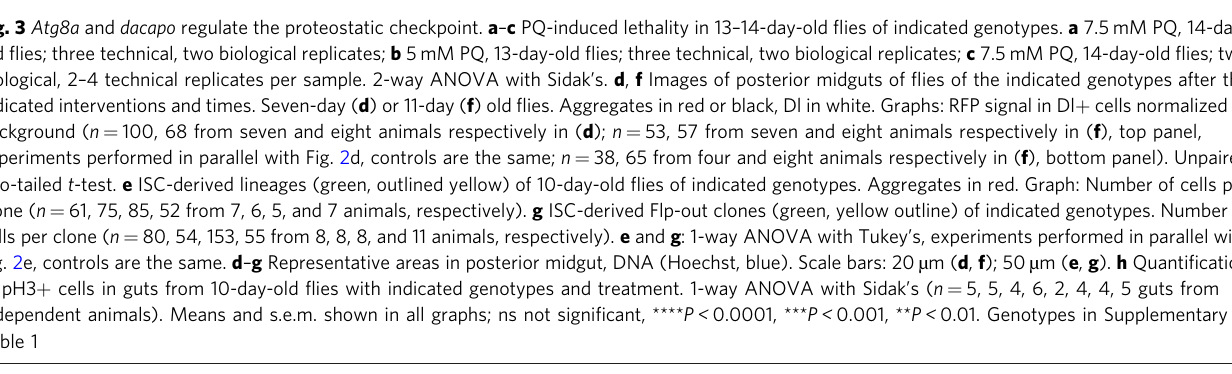
Fig. 3 Atg8a and dacapo regulate the proteostatic checkpoint. a – c PQ-induced lethality in 13 – 14-day-old fl ies of indicated genotypes. a 7.5 mM PQ, 14-day- old fl ies; three technical, two biological replicates; b 5 mM PQ, 13-day-old fl ies; three technical, two biological replicates; c 7.5 mM PQ, 14-day-old fl ies; two biological, 2 – 4 technical replicates per sample. 2-way ANOVA with Sidak ’ s. d , f Images of posterior midguts of fl ies of the indicated genotypes after the indicated interventions and times. Seven-day ( d ) or 11-day ( f ) old fl ies. Aggregates in red or black, Dl in white. Graphs: RFP signal in Dl + cells normalized to background ( n = 100, 68 from seven and eight animals respectively in ( d ); n = 53, 57 from seven and eight animals respectively in ( f ), top panel, experiments performed in parallel with Fig. 2d, controls are the same; n = 38, 65 from four and eight animals respectively in ( f ), bottom panel). Unpaired two-tailed t -test. e ISC-derived lineages (green, outlined yellow) of 10-day-old fl ies of indicated genotypes. Aggregates in red. Graph: Number of cells per clone ( n = 61, 75, 85, 52 from 7, 6, 5, and 7 animals, respectively). g ISC-derived Flp-out clones (green, yellow outline) of indicated genotypes. Number of cells per clone ( n = 80, 54, 153, 55 from 8, 8, 8, and 11 animals, respectively). e and g : 1-way ANOVA with Tukey ’ s, experiments performed in parallel with Fig. 2e, controls are the same. d – g Representative areas in posterior midgut, DNA (Hoechst, blue). Scale bars: 20 µ m ( d , f ); 50 µ m ( e , g ). h Quanti fi cation of pH3 + cells in guts from 10-day-old fl ies with indicated genotypes and treatment. 1-way ANOVA with Sidak ’ s ( n = 5, 5, 4, 6, 2, 4, 4, 5 guts from independent animals). Means and s.e.m. shown in all graphs; ns not signi fi cant, **** P < 0.0001, *** P < 0.001, ** P < 0.01. Genotypes in